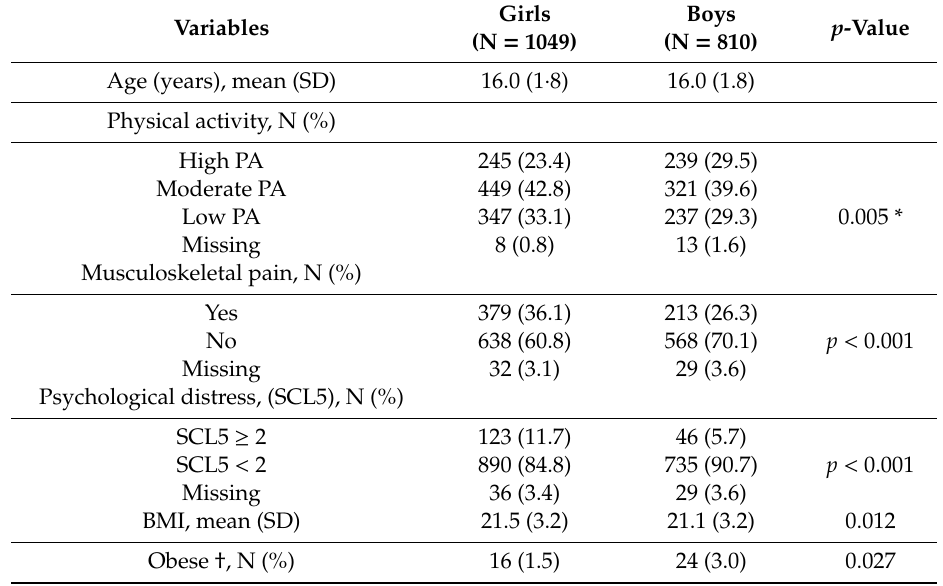
Table 1. Participants’ characteristics at baseline–nord-trøndelag health study in norway (Young-HUNT1).